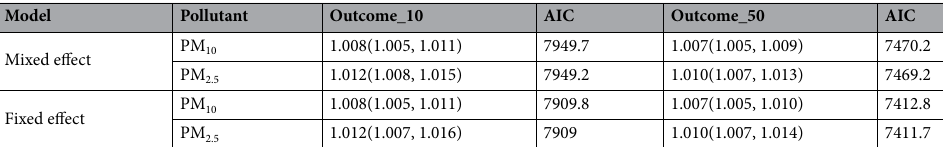
Table 2. Association between long term exposure to particulate matter and Covid-19 cases at regional level estimated with negative binomial regression models with country entered as random (mixed effect model) or fixed (fixed effect model). Models adjusted for total population, proportion of population aged 65 or up, sex, temperature, relative humidity, diabetes prevalence, gross domestic product per individual, cumulative number of tests at outcome date, Government Response Stringency Index at outcome date and spatial components entered as cubic splines. Outcomes are the cumulative number of cases in the 14 days following the day when the 10th (Outcome_10) or 50th (Outcome_50) case were reported in each region. Reported values are the exponentiated betas and 95% confidence